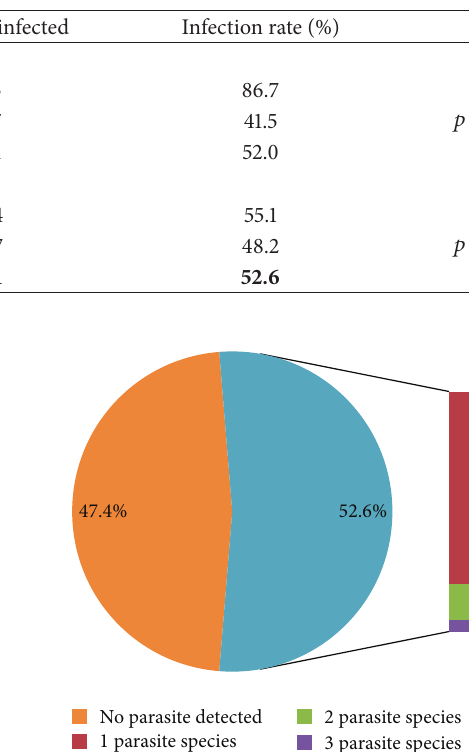
Table 1: Prevalence of helminths in dogs in relation to age and sex ( 𝑁 = 154 ).